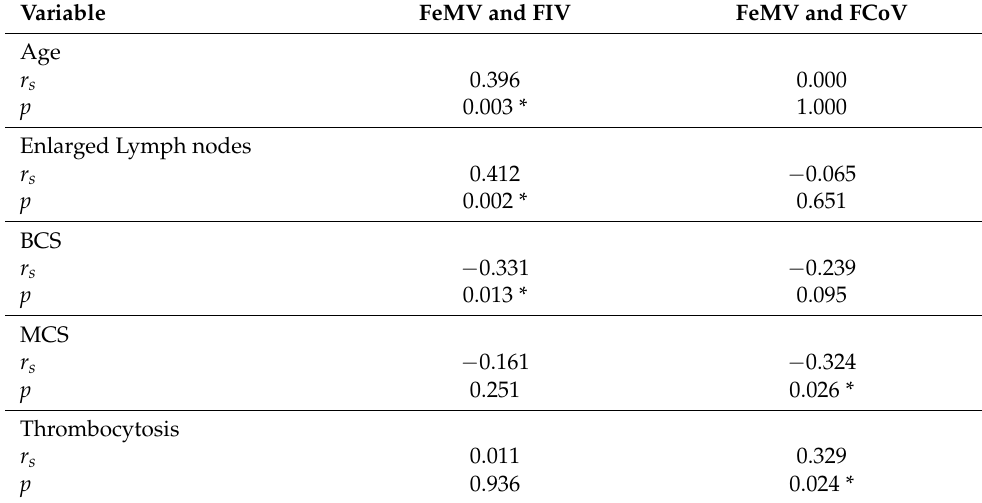
Table 8. Description of significant (*) Spearman’s rank correlation coefficient ( r s ) and p values of variables significantly correlated to coinfection between FeMV (Ab + and/or RNA + ) and FIV (Ab + and/or RNA + ) or FeMV (Ab + and/or RNA + ) and FCoV (RNA + ) when compared to cats that were positive only for FeMV (Ab + and/or RNA +